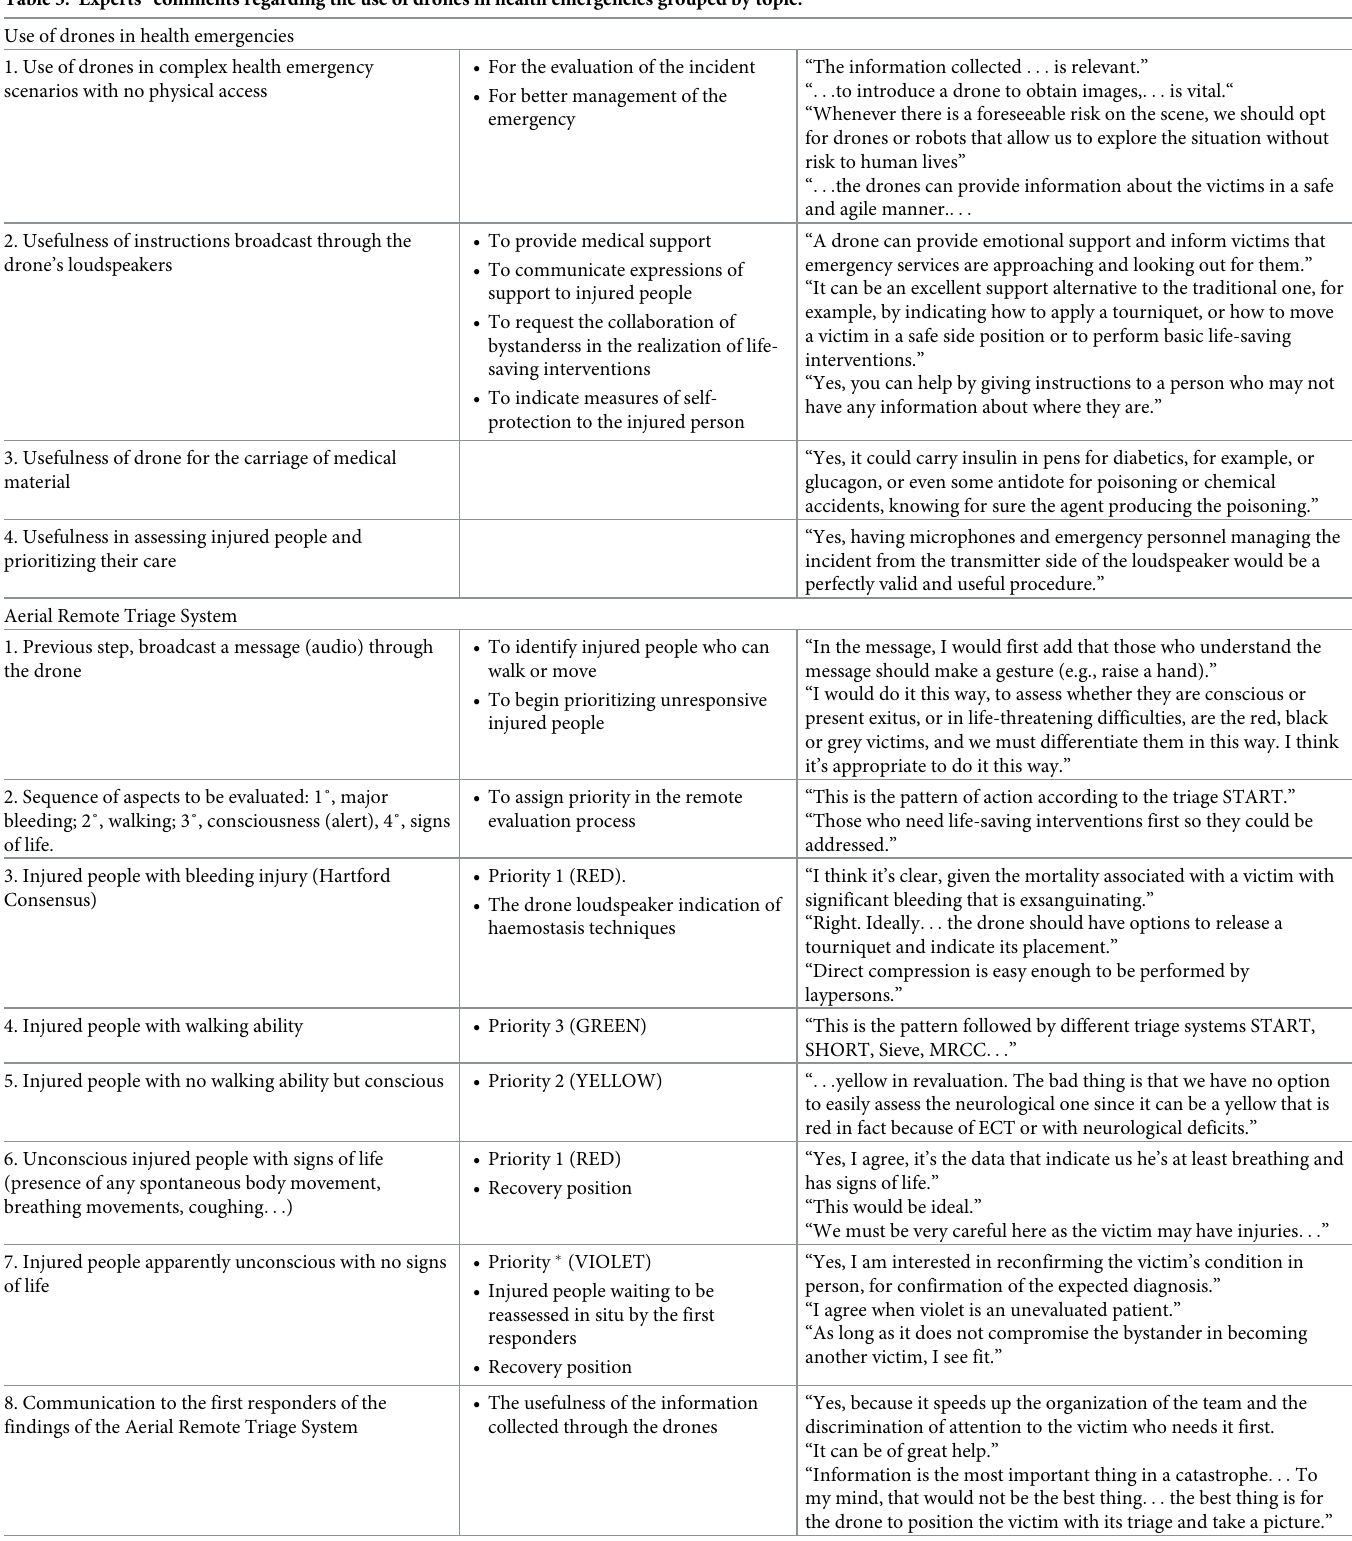
Table 5. Experts´ comments regarding the use of drones in health emergencies grouped by topic. Use of drones in health